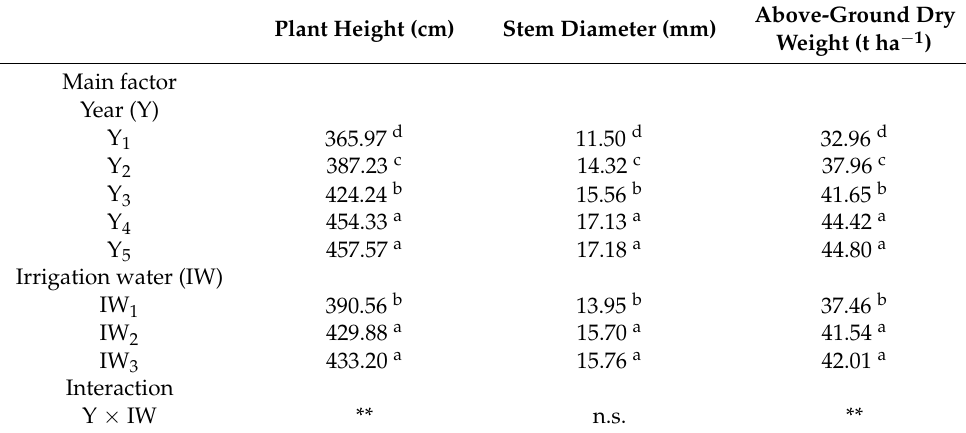
Table 7. Morphological and production characteristics of giant reed plants in response to year and irrigation water during the study period. Average values of 5-year tests are shown. Above-Ground Plant Height (cm) Stem Diameter (mm)